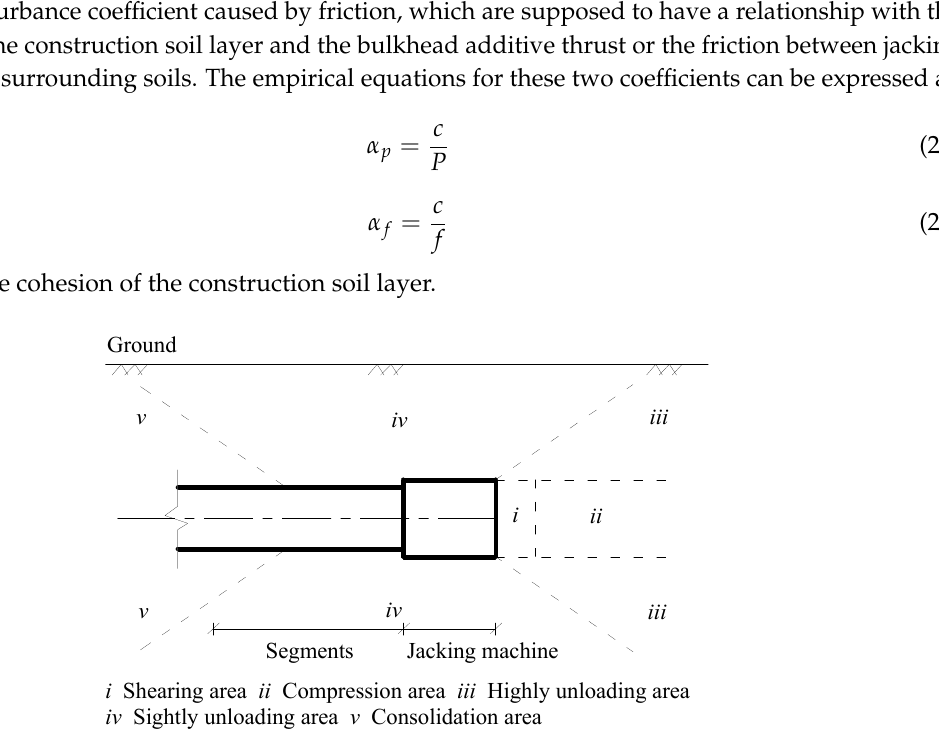
Figure 4. Districts of surrounding soils under the disturbance of pipe-jacking.